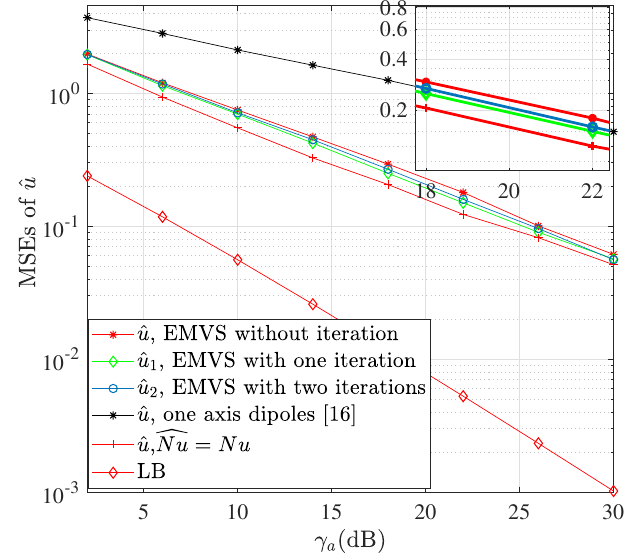
Figure 4. The MSEs of ˆ u versus γ a .